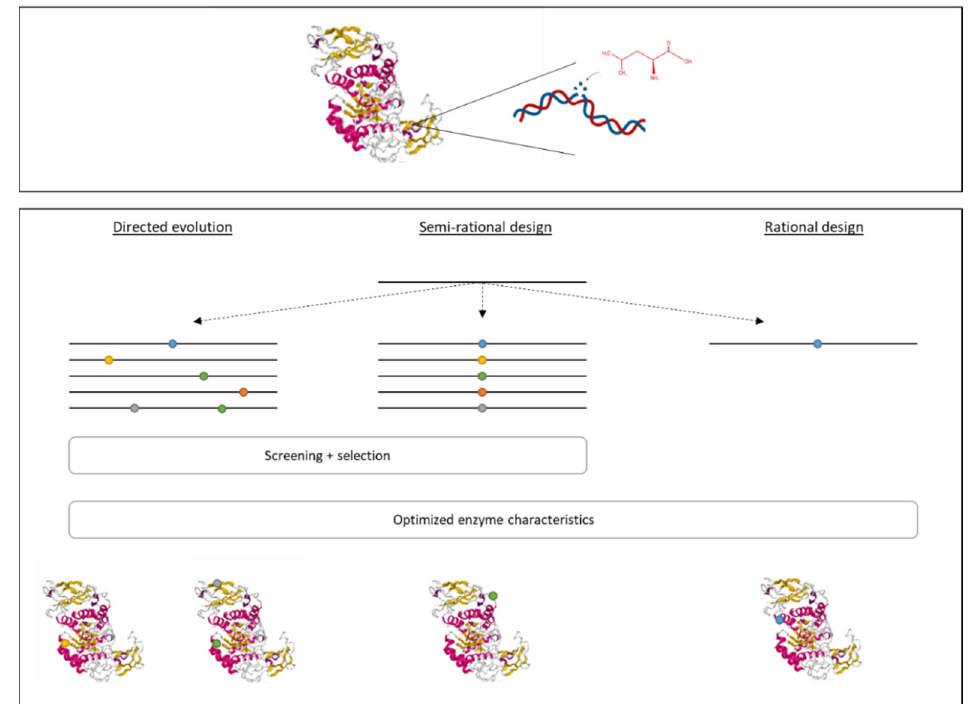
Figure 2. The construction of recombinant proteins can be done using three different approaches. Rational design is used to modify a specific amino acid that is known to be related to characteristics that need to be changed. If no information is known about the enzyme’s structure and mechanism, both directed evolution and semi-rational design can be used. For directed evolution, a library is prepared of random mutations, mimicking evaluation. This is followed by a thorough screening and selection process. The semi-rational design combines the knowledge of the enzyme’s structure to know where a change is needed with the methodology of directed evolution to prepare a library of mutations within a specific region.